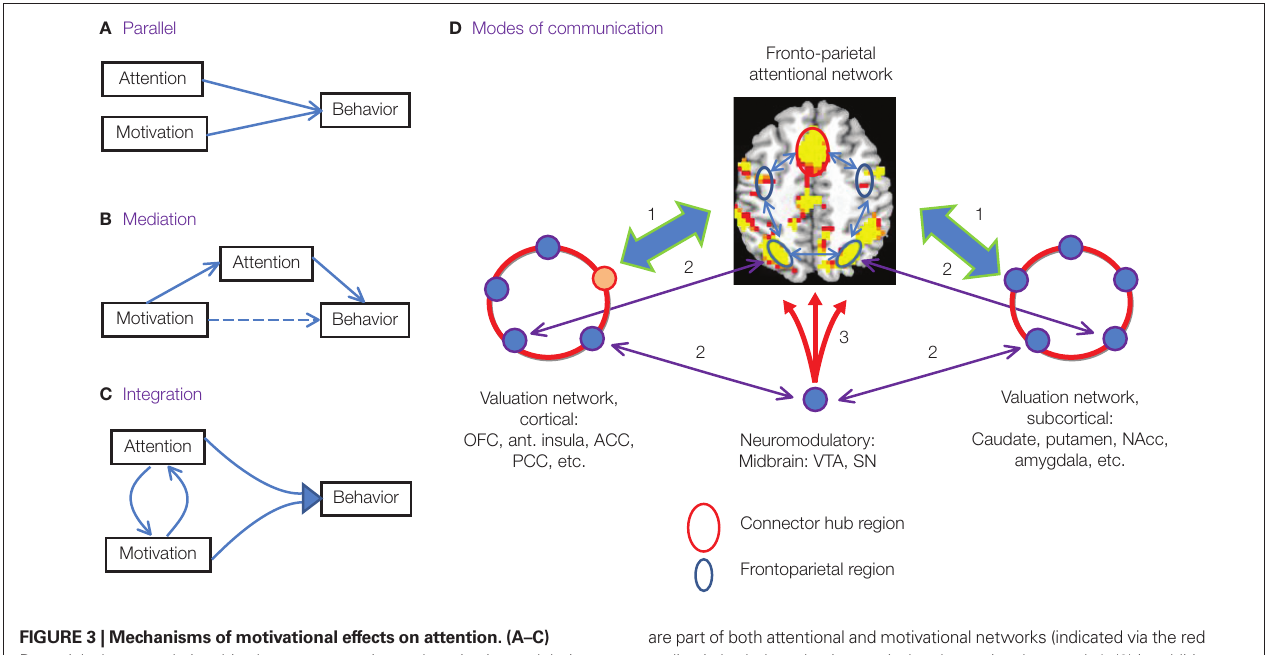
Figure  | Mechanisms of motivational effects on attention. (A–C) Potential, abstract relationships between attention and motivation and their effects on behavior. (D) Modes of communication between cognitive and motivation networks illustrated for attentional-motivational interactions. (1) Interactions rely on “hub” regions, such as the anterior cingulate cortex, which